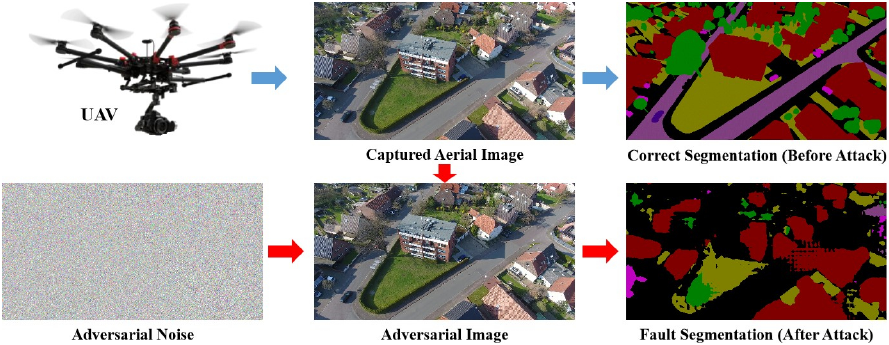
Figure 1. Illustration of the adversarial examples attack on aerial image semantic